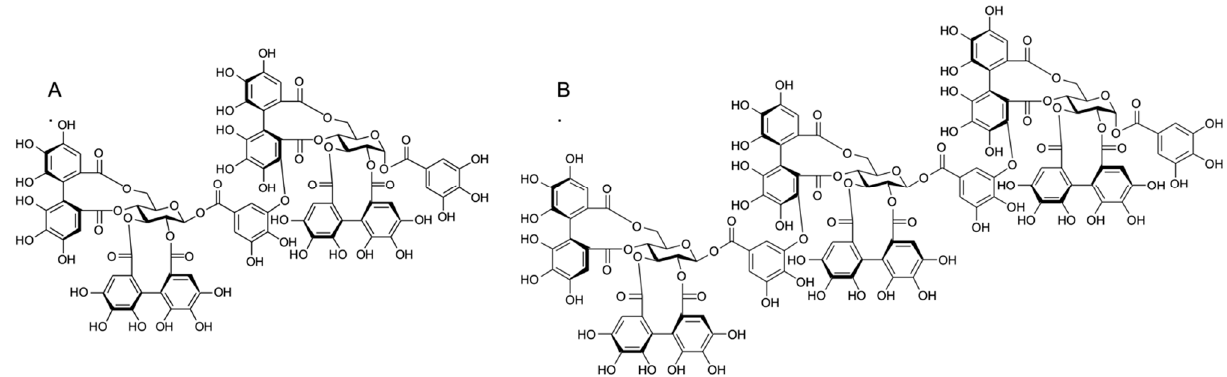
Figure 1. Chemical structure of sanguiin H-6 ( A ) and lambertianin C ( B